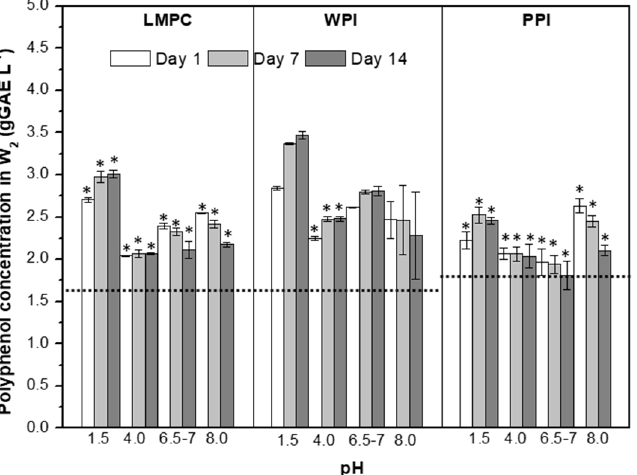
Figure 6. Polyphenol concentration in W 2 of emulsions stabilized with LMPC, WPI and PPI during a quiescent storage at pH 1.5, 4.0, 6.5–7, and 8.0 over 14 days at room temperature. Asterisk labels above the bars point out the appearance of a precipitate during polyphenol analysis. Dashed lines indicate the value in freshly produced emulsions.